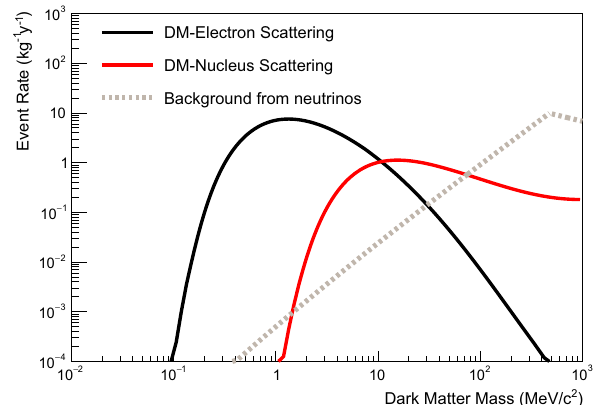
Fig. 14 Shown is the projected event rate for a year exposure assumed a DM-nucleon cross section of 5 × 10 − 45 cm 2 and a DM-electron cross section calculated using Eq. 24. The background events are assumed to be constrained by neutrino induced nuclear recoils per kg per year